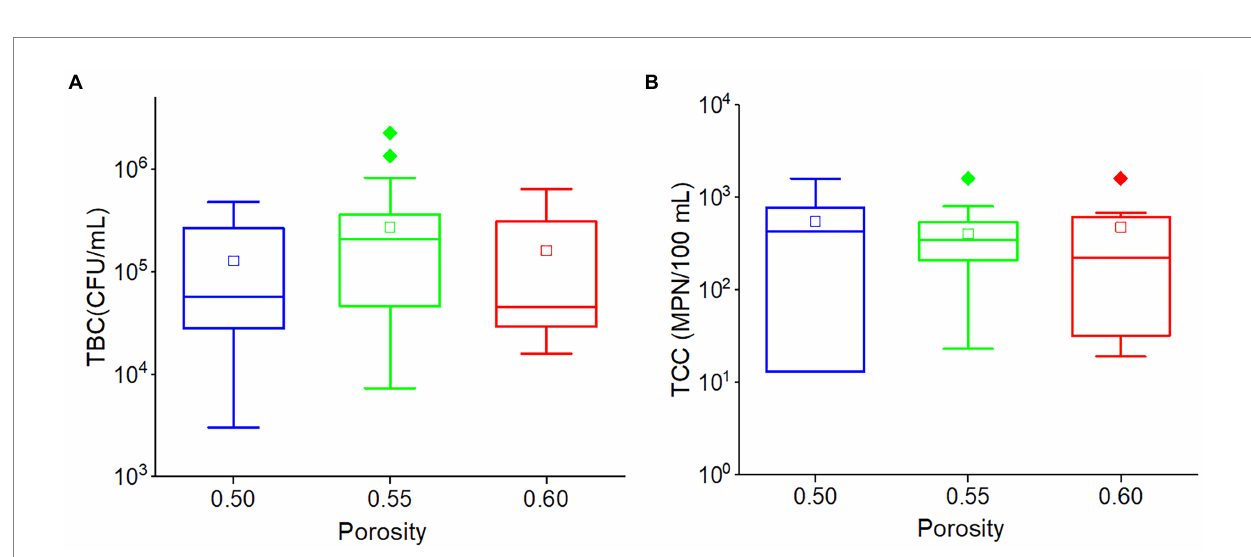
FIGURE 6 The box plots of (A) TBC and (B) TCC in various porosities. Different colors stand for different porosities. The central line and square of each box are the median and mean values, respectively, while the top and bottom of each box represent the third and first quartile, respectively. Whiskers on the box plot represent maximum and minimum values, while rhombuses above or below the box plots show outliers in the